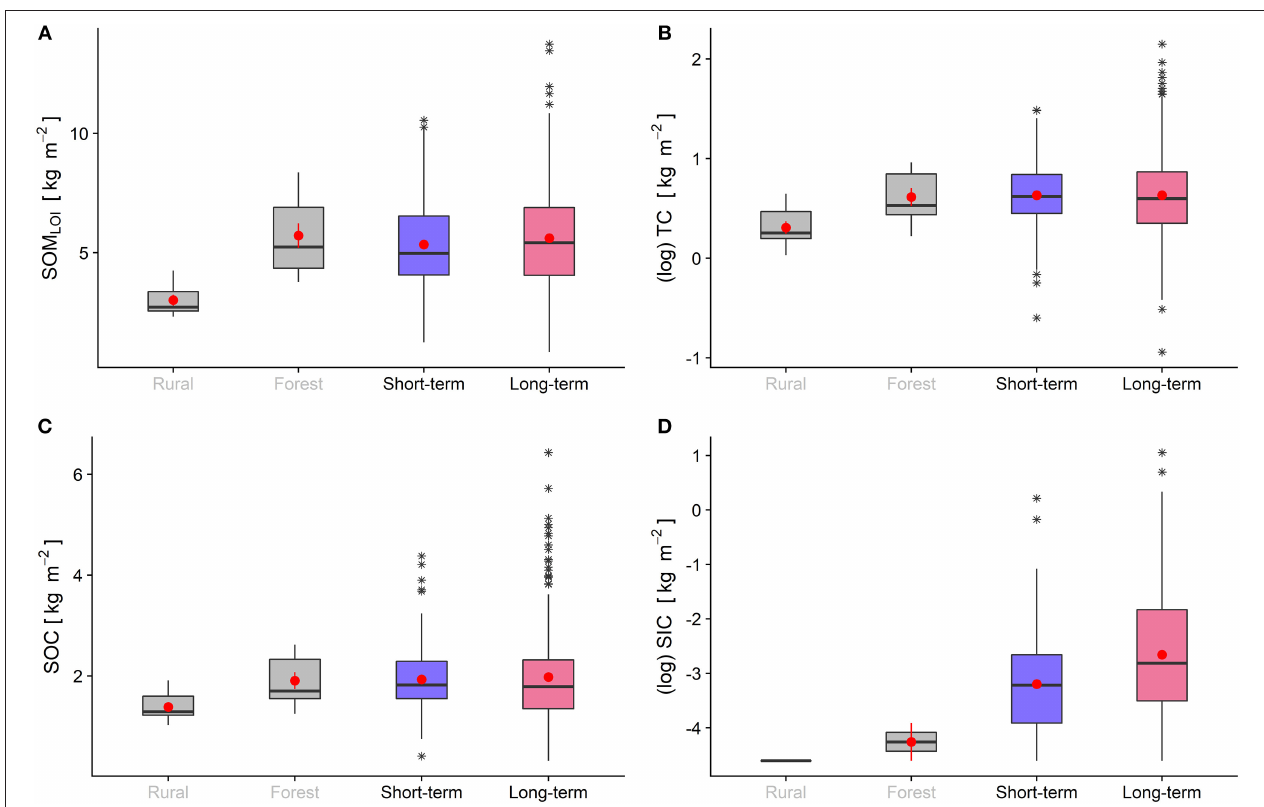
FIGURE 8 | Boxplots comparing rural, forest and urban soils with respect to their amounts per m 2 (in the upper 10cm) of (A) SOM LOI , SOM obtained from loss on ignition; (B) TC, total carbon; (C) SOC, soil organic carbon; (D) SIC, soil inorganic carbon. Arithmetic means (red points), standard errors (red whiskers), medians (bars), ranges (whiskers), and outliers (asterisks) are shown.